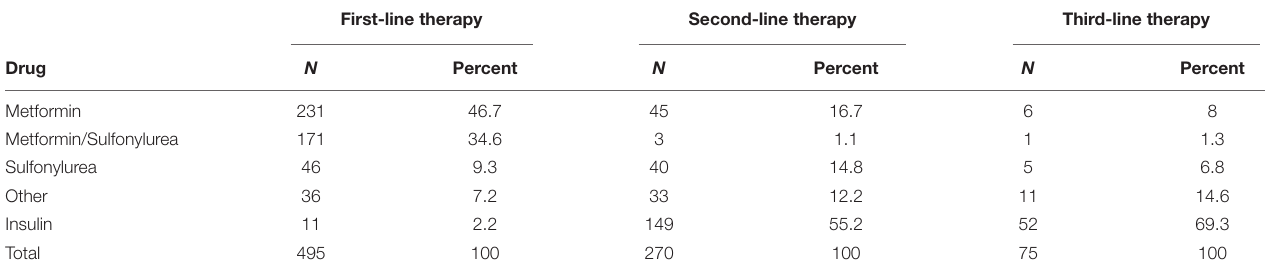
TABLE 2 | Scheme for the treatment of T2DM.